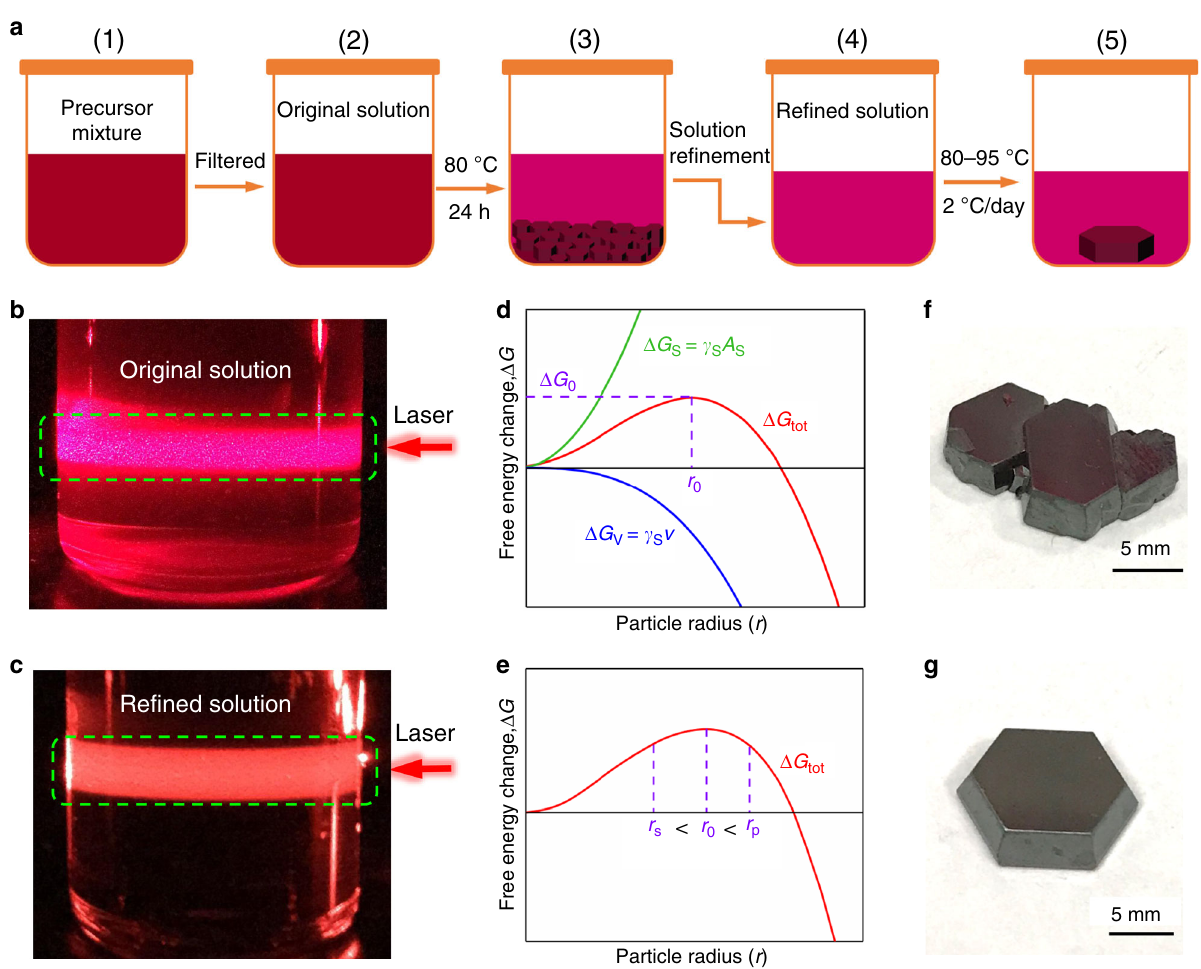
Fig. 1 Crystallization of Cs 3 Bi 2 I 9 perovskite single crystal (PSC). a Schematic of the nucleation-controlled method to grow Cs 3 Bi 2 I 9 PSCs. b , c The red laser beams illuminate on the original solution and re fi ned solution. d , e Schematic illustrations of the Gibbs free energy change as a function of particle radius for homogeneous nucleation. ( Δ G tot is the total Gibbs free energy change due to the change of surface area ( Δ G s) and the volume ( Δ G v). Δ G 0 is the free energy change at the critical nucleation point, and r 0 is the critical particle radius). f , g Photographs of Cs 3 Bi 2 I 9 PSCs grown using the original solution and re fi ned solution. Scale bar, 5